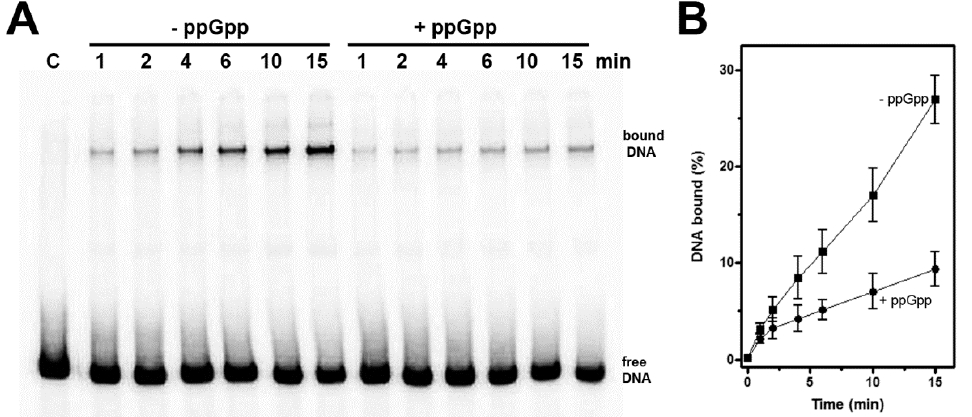
Figure 5. (p)ppGpp destabilizes the RNAP- hns promoter complex. EMSA was carried out as described in Materials and Methods by incubating for the indicated times, a [ 32 P]-labeled DNA fragment (221 bp), corresponding to hns promoter with RNA polymerase in the absence or presence of ppGpp (500 µ M) ( A ). The electrophoretic migrations of free DNA and hns DNA-RNAP complex are indicated and C is the control sample in absence of protein. Radioactivity associated to free and bound DNA was quantified and complexed DNA has been expressed as percentage ( B ). A representative gel is shown, and the average of four independent experiments and standard deviation are